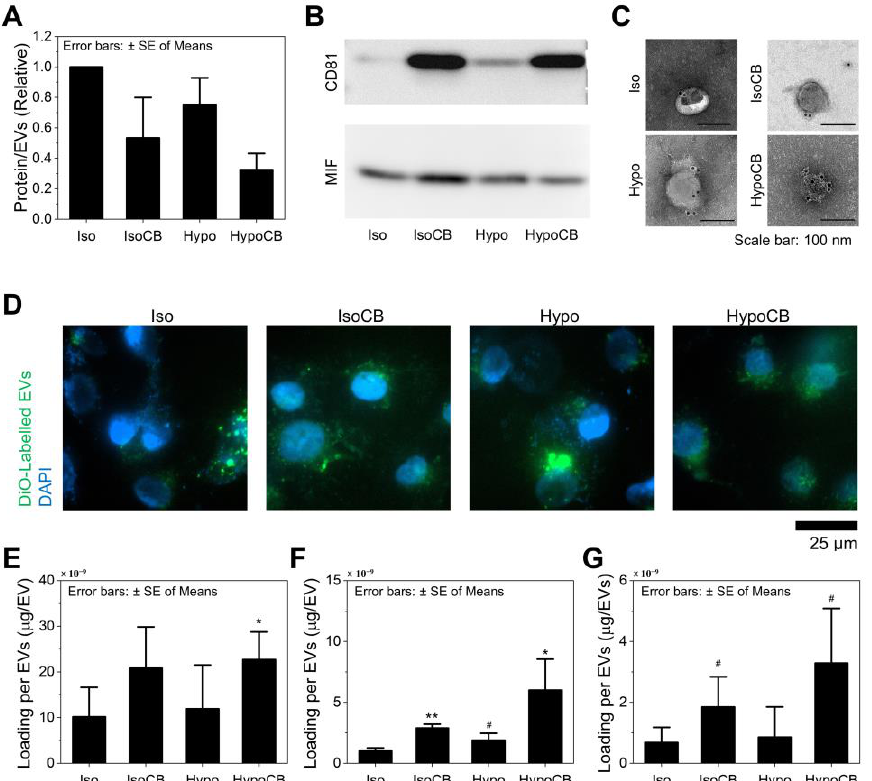
Figure 4. The proteins expressions, cellular uptake, and dendrimer loading capability of hypo-CIMVs compared to naturally-secreted EVs, hypo-EVs, and CIMVs: ( A ) Amount of total vesicular protein ( n = 3); ( B ) Expression of transmembrane protein CD81 compared to intravesicular protein MIF; ( C ) Immunogold TEM images for assessing the CD63 (transmembrane marker) expression; ( D ) Cellular uptake of the produced EVs; ( E – G ) Loading of ( E ) G7-NH2, ( F ) G7-COOH, and ( G ) G7-Ac to the produced EVs. Significance levels are indicated as # p < 0.10, * p < 0.05, and ** p < 0.01, compared to the EVs obtained from non-CB treated cells. The dendrimer loading to the EVs was analyzed from at least three independent experiments ( n ≥ 3).